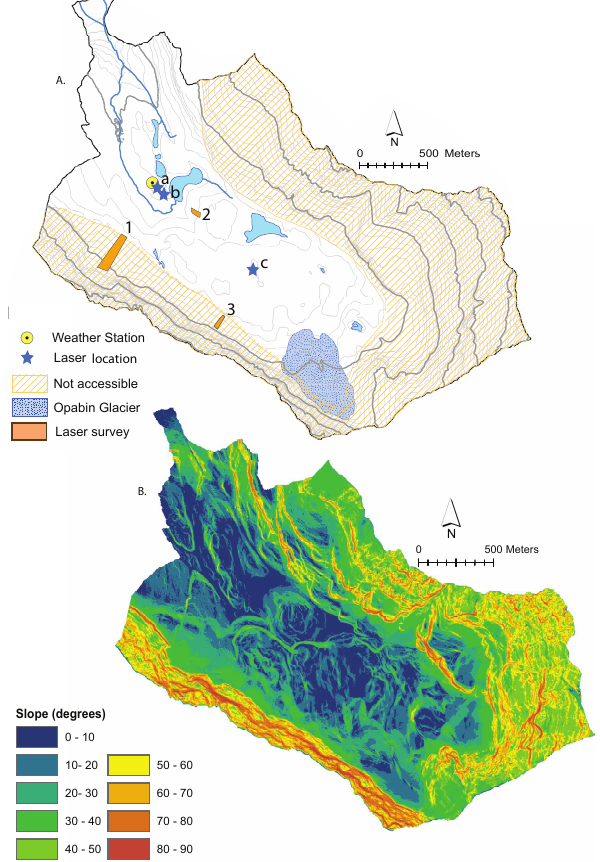
Fig. 1. (A) Opabin watershed map with locations of laser surveys (1-lower talus, 2-validation slope, 3-upper talus), laser position (a- lower talus, b-validation slope, c-upper talus) and inaccessible area. Contour interval 25m. (B) Opabin watershed slope